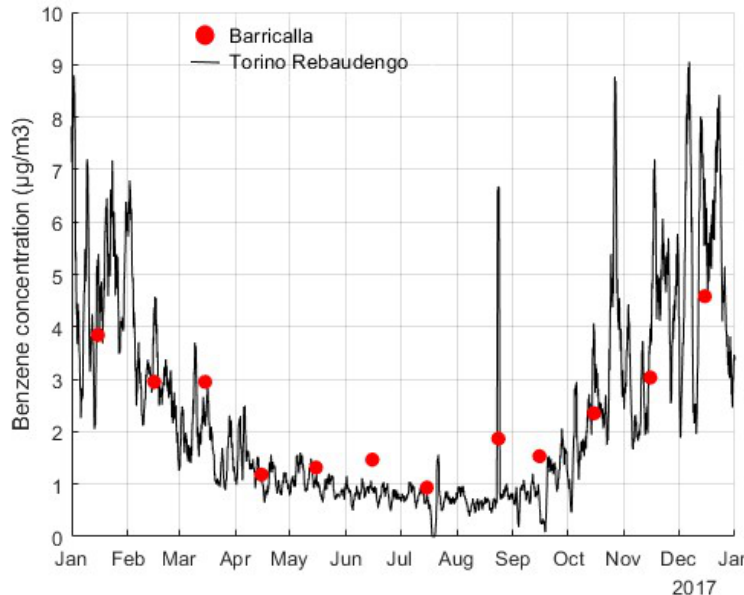
Figure 9. The concentration of benzene in 2017 in Turin. Comparison between the Torino Rebaudengo station and the Barricalla site.